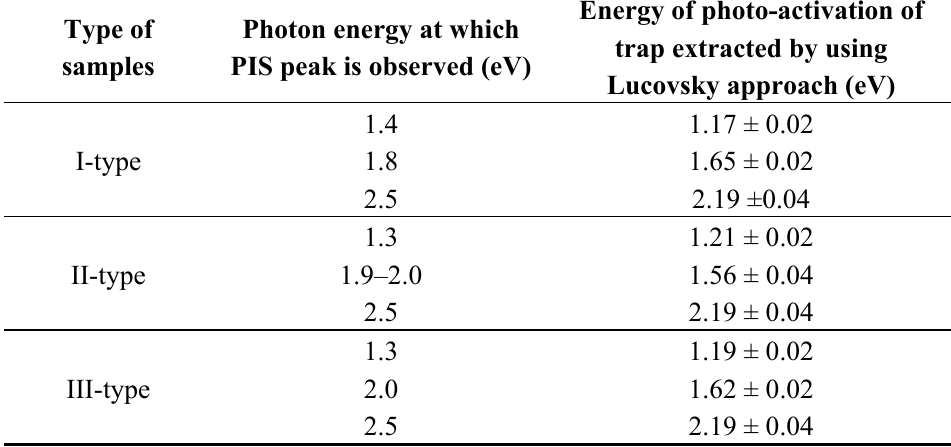
Table 2. Photo-ionization spectroscopy (PIS) peaks obtained within spectra of different types of